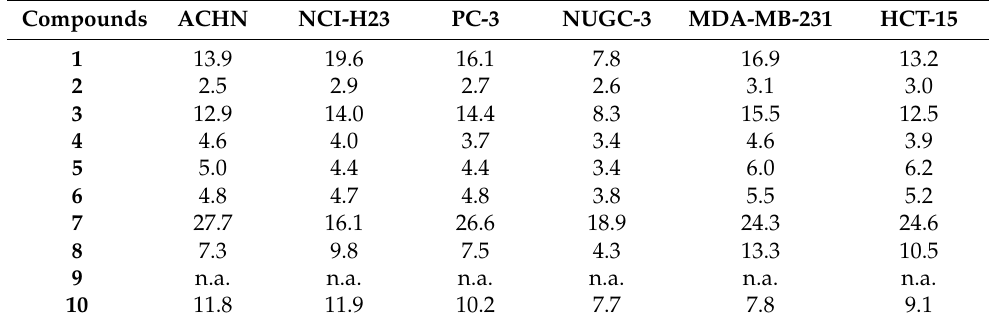
Table 4. Growth inhibition (GI 50 , µ M) of 1 – 11 and 13 – 16 against human cancer cell